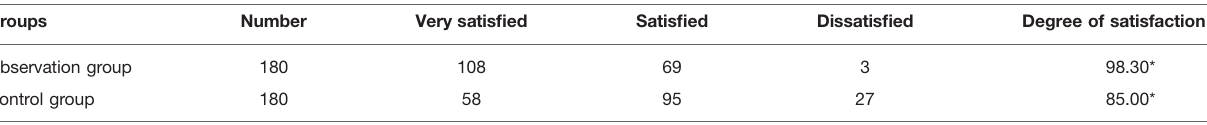
TABLE 3 | Comparison of nursing satisfaction between two groups ( n =360, %).